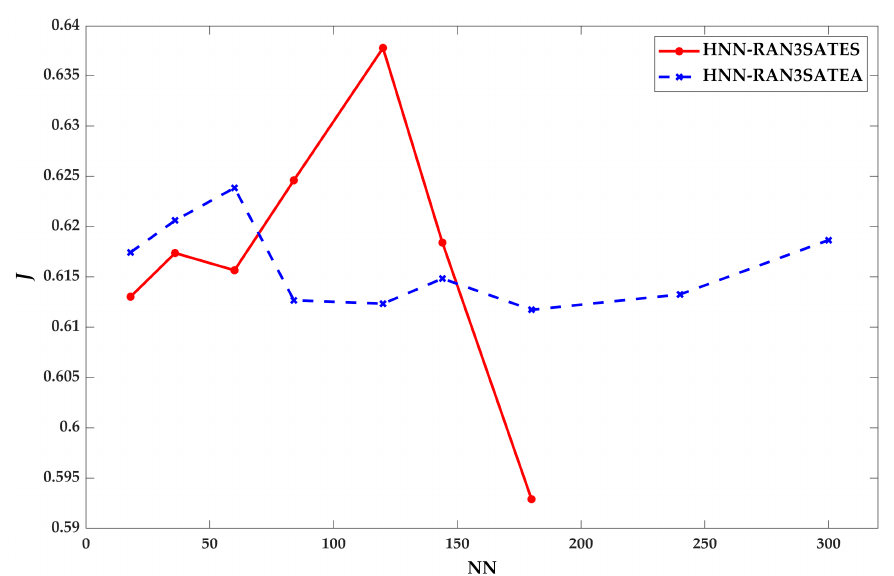
Figure 10. J (Jaccard) for HNN-RAN3SAT model.